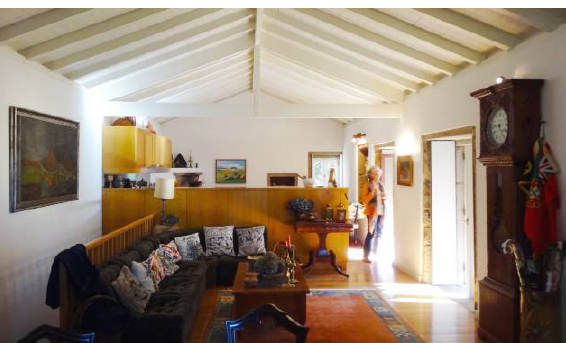
Figure 9. First floor: open-space kitchen and sitting